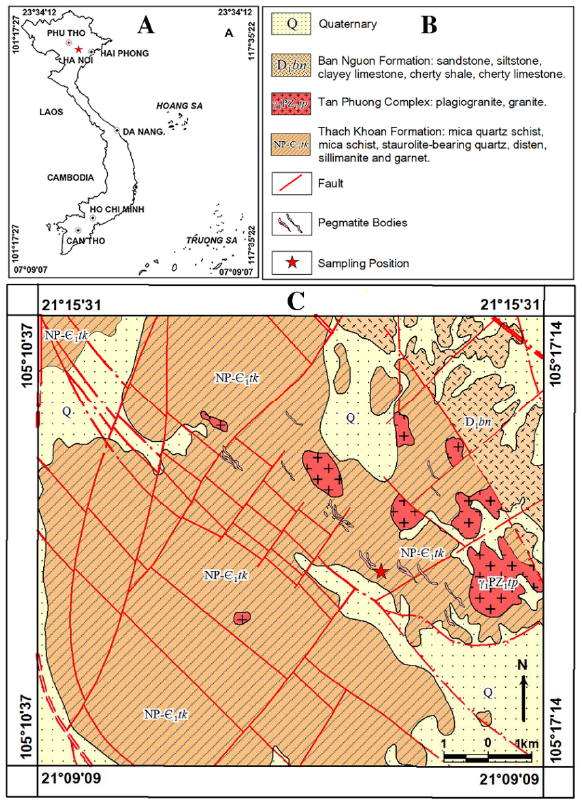
Figure 1. Vietnam map and the site of the study area ( A ); geological legend ( B ) and geological map of the study area ( C ).